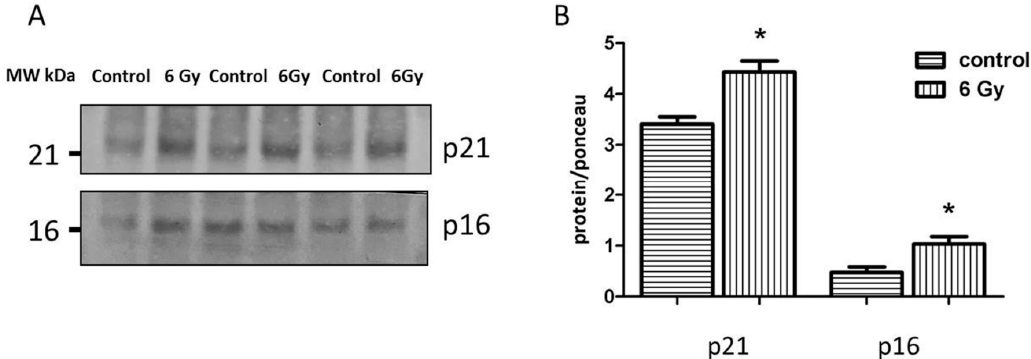
Figure 7. Analysis of the senescence-associated proteins. Immunoblotting analysis of the senescence markers (p21 and p16) in whole heart lysate ( A and B ). The amount of the total protein was measured by Ponceau S staining for an accurate comparison between the groups. The error bars represent standard error of the mean (± SEM) (t-test; * p < 0.05; n = 3).